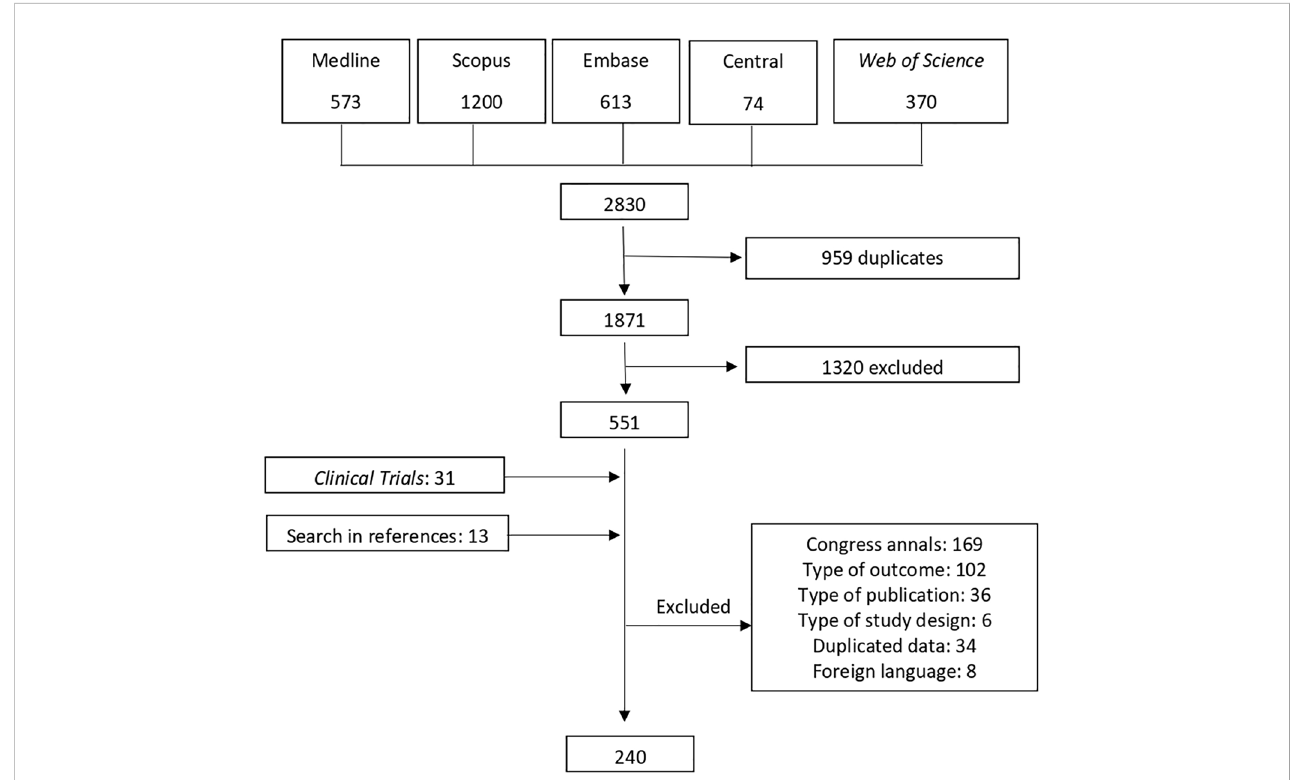
FIGURE 1 Flow diagram of the stages of study selection; NRCT, Non-randomized clinical trial; RCT, Randomized clinical